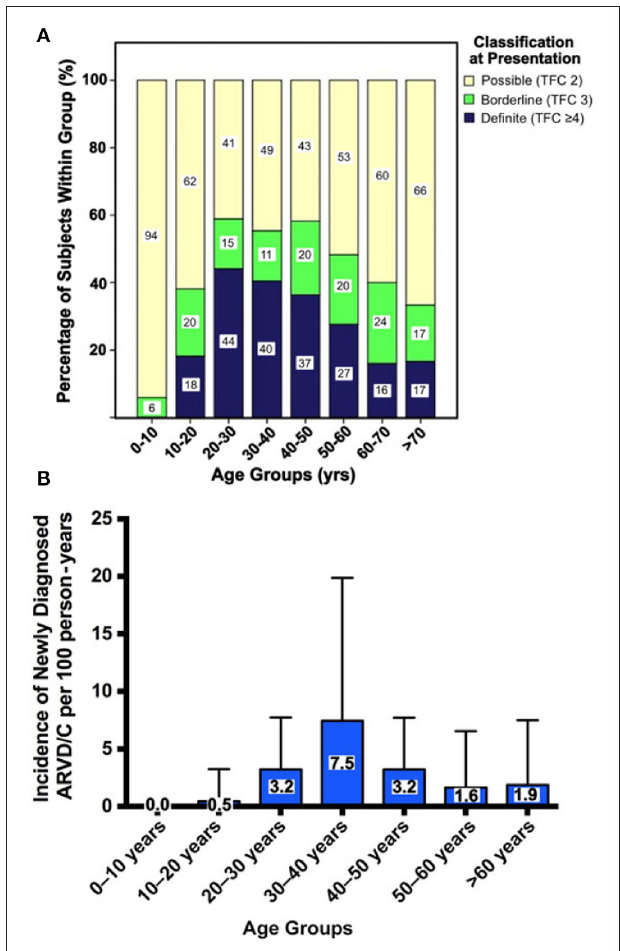
FIGURE 9 | Age-related penetrance of ARVC diagnoses among 274 family members screened for disease. (A) Cross-sectional prevalence of ARVC. All family members are stratified by age at evaluation, where each age group is scaled to 100% to show the proportion of family members with definite, borderline, or possible disease at time of evaluation. (B) Incidence of newly diagnosed ARVC per 100 person-years during prospective follow-up. Error bars denote upper limit of 95% confidence interval. Source: ( 89), obtained with